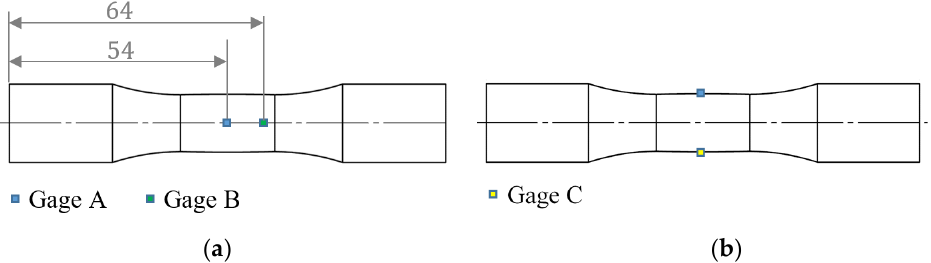
Figure 2. Location of the strain gages used for the calibration of the applied stress amplitude: ( a ) stress distribution validation; ( b ) bending validation.